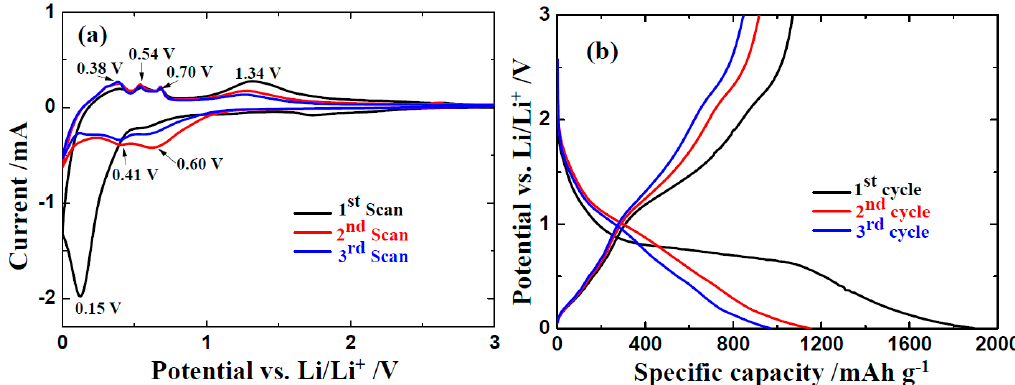
Figure 4. ( a ) CV curves of the ZnO/NG composite electrode at a scan rate of 0.1 mV s − 1 and ( b ) discharge/charge profiles of ZnO/NG anode at 100 mA g − 1